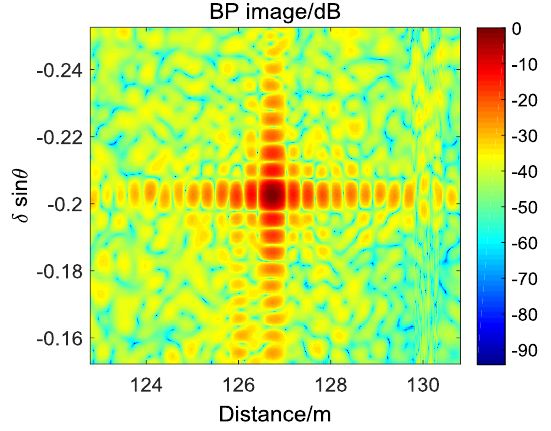
Figure 22. Imaging of corner reflector.